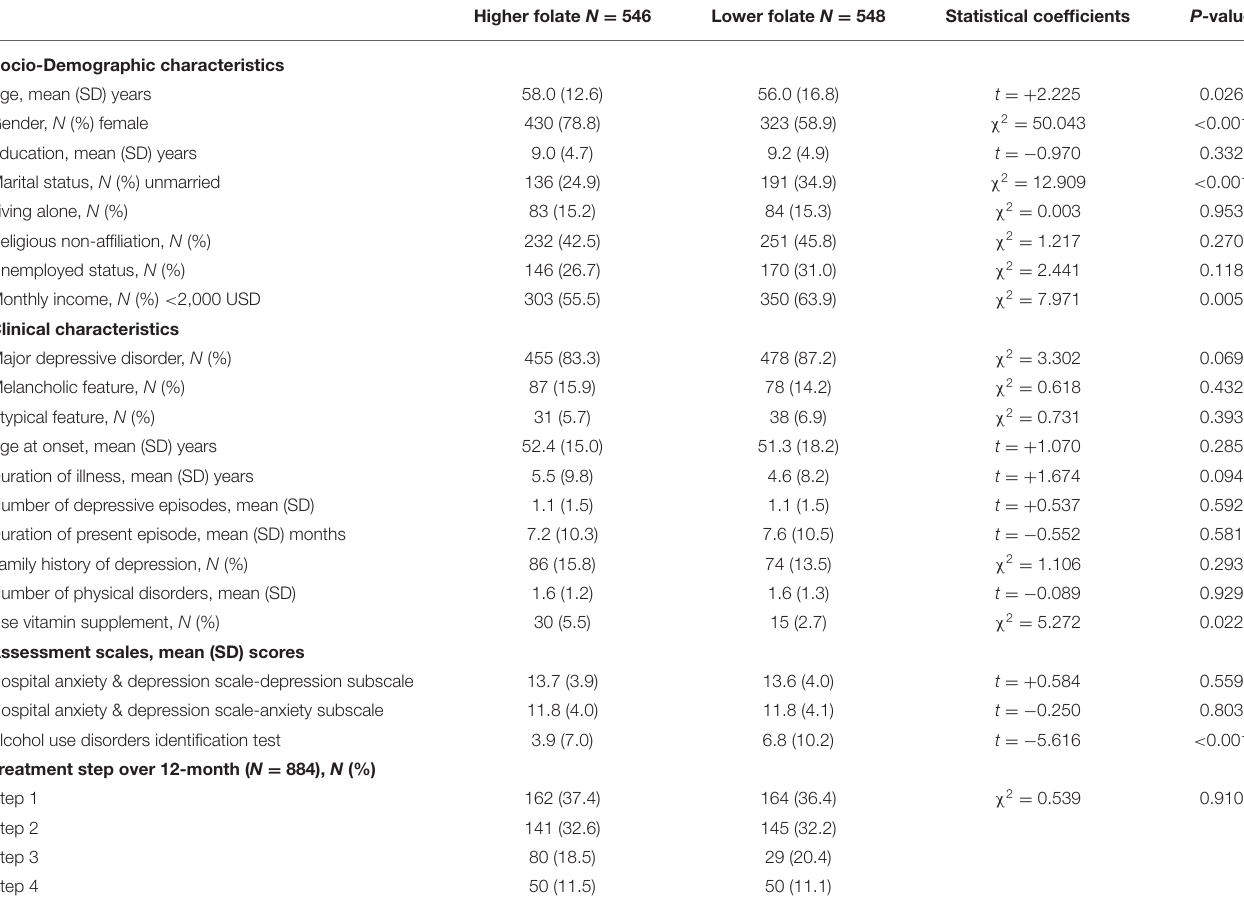
TABLE 1 | Characteristics compared by folate levels above/below median value (7.4ng/mL) at baseline. Higher folate N = 546 Lower folate N = 548 Statistical coefficients P